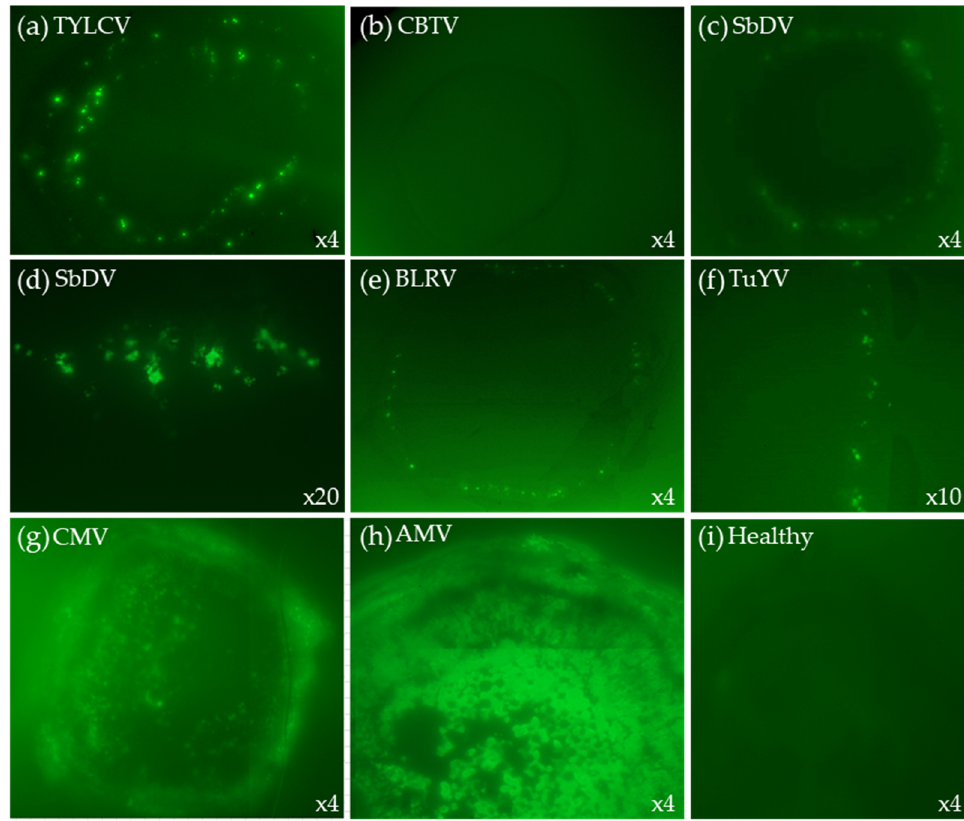
Figure 6. The TB-HCR using 488-HPs. The TYLCV blots were probed with TYLCV-P1, -P3, and -P4. SbDV, TuYV, BLRV, and CBTV (neg control) were probed with HCR-A1, -A2, and -A3. CMV was probed with all six CMV-SG probes and AMV was probed with two AMV-CP probes. After probing, the blots were incubated with Alexa Fluor 488 hairpins.